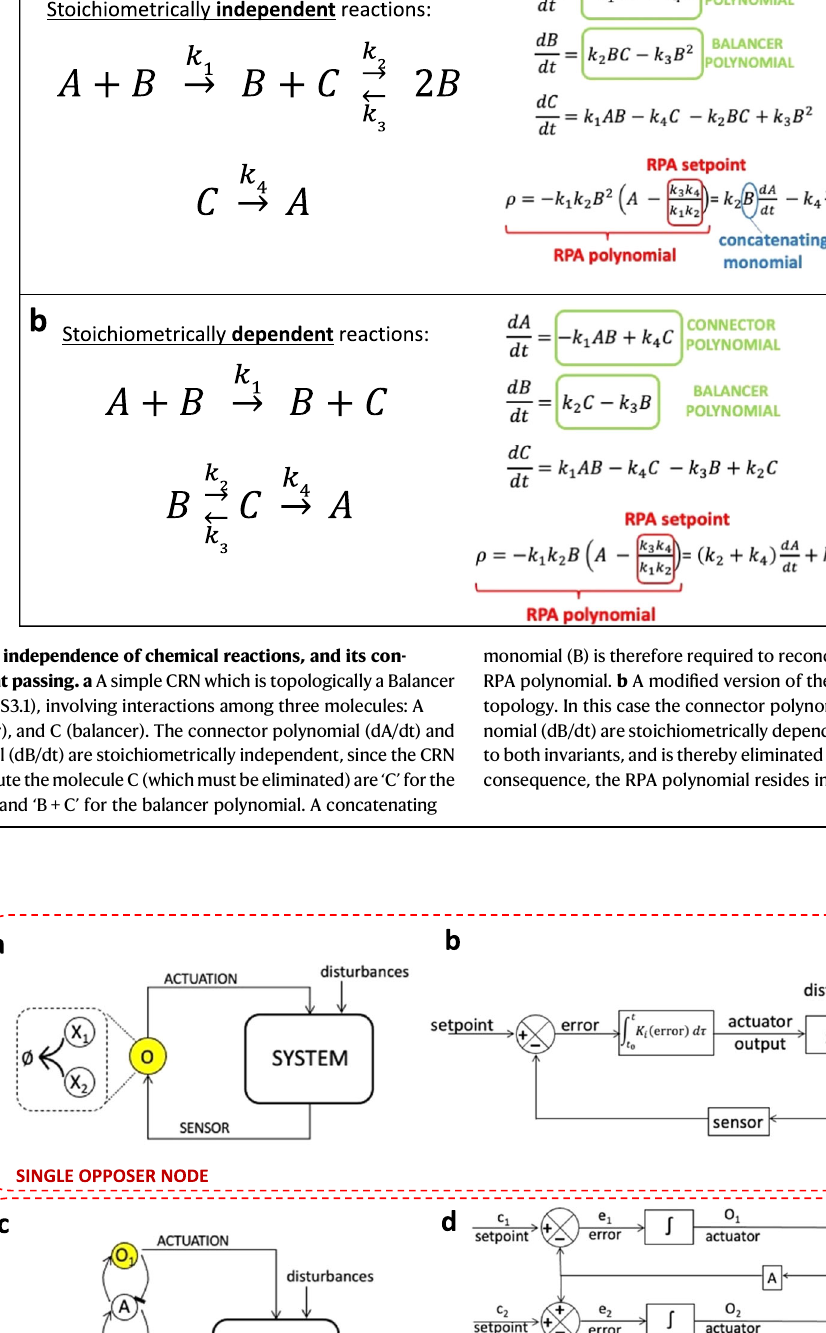
Fig. 9 | The distribution of internal models into a topological hierarchy. a A network with a single integral controller. b A standard integral feedback control diagram, in which the error between the setpoint and sensor for the system is integratedinasingleintegral,correspondingtoasingleinternalmodel. c InCRNs,a universal description of integral control is obtained by decomposing the internal model into multiple subsidiary internal models, each corresponding to a linear coordinate change, and each corresponding to an (algebraically) independent